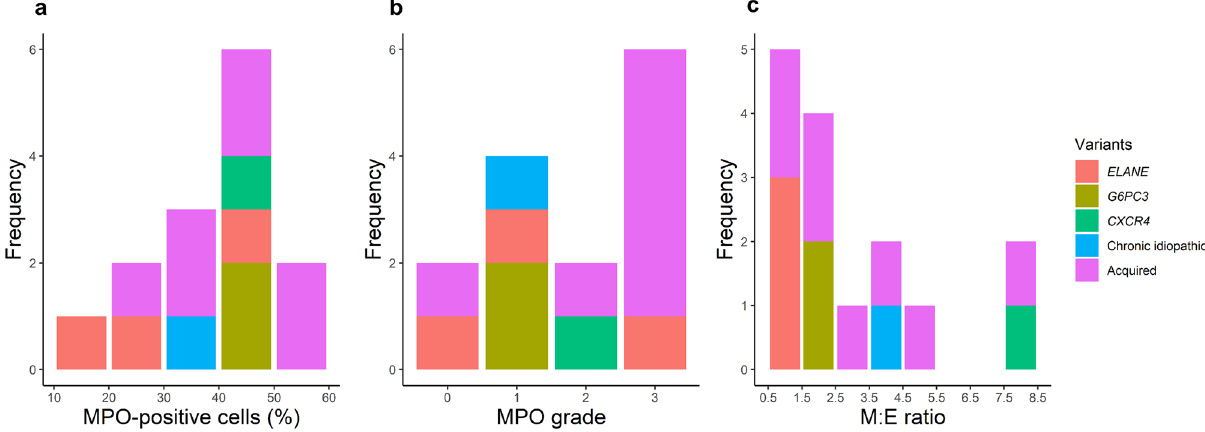
Figure 3. Distributions of MPO-positive cells, MPO grade and M:E ratio in the context of genetic variants. The percentage of MPO-positive cells ranged from 40 to 60% in patients with acquired neutropenia. Two of the 3 patients with pathogenic ELANE mutations showed 10%–30% of MPO-positive cells, while one patient showed 40%–50%. Three patients with pathogenic G6PC3 and CXCR4 mutations whose BM displayed myelokathexis had 40%–50% of MPO-positive cells. Two patients with VUS in CXCR2 and acquired neutropenia showed 50%–60% of MPO-positive cells, which was higher than in patients with myelokathexis. The MPO grade of patients with acquired neutropenia was 2 or 3. Three patients with pathogenic ELANE mutations showed various distributions of MPO grade. BM with the pathogenic CXCR4 mutation had MPO grade 2, whereas BM with G6PC3 mutations had MPO grade 1. The M:E ratio of patients with ELANE mutations ranged from 0.5 to 1.5, which was lower than normal. G6PC3 -mutated patients had an M:E ratio of 1.5–2.5, whereas a patient with the CXCR4 mutation had an increased M:E ratio of